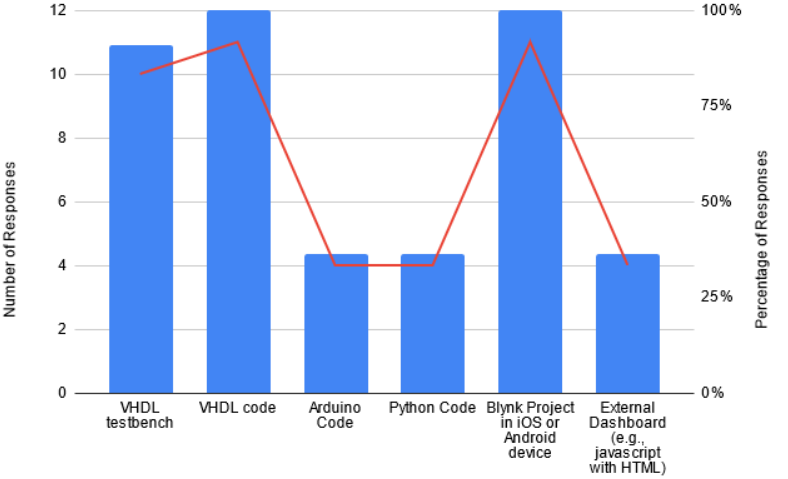
Figure 10. Artefacts developed by students in the